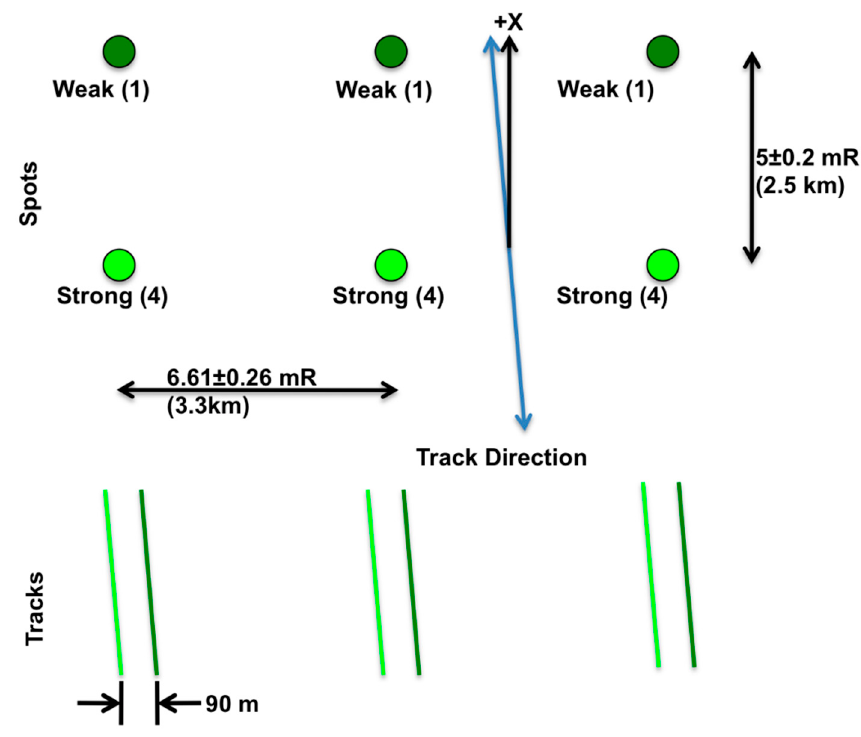
Figure 2. Beam distribution of ATLAS under the forward flight mode (+x direction) (https://icesat-2.gsfc.nasa.gov (accessed on 2 January 2021)).